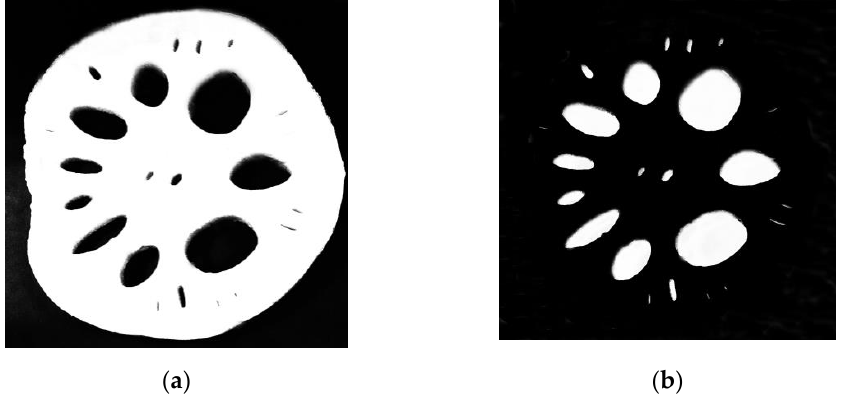
Figure 7. Images of a slice of the testing lotus root. ( a ) White pulp; ( b ) White stomata. Table 5. Volume and density of